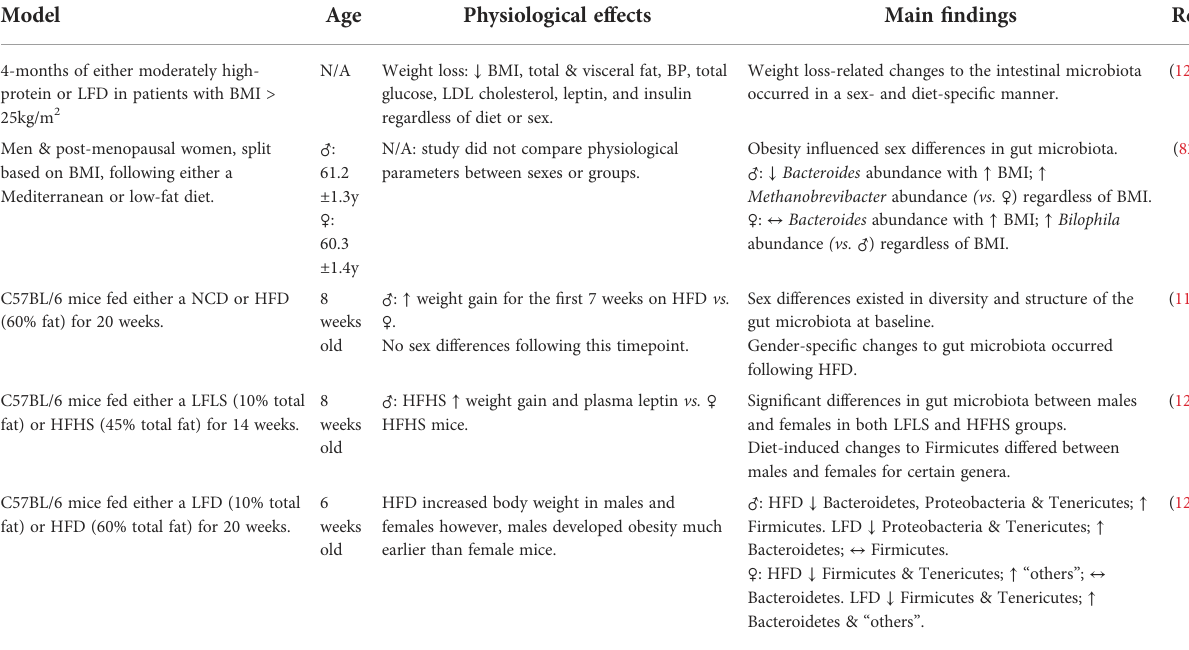
TABLE 1 Summary of human and mouse studies investigating the sexual dimorphisms of intestinal microbiota in obesity. Model Age Physiological effects Main fi ndings